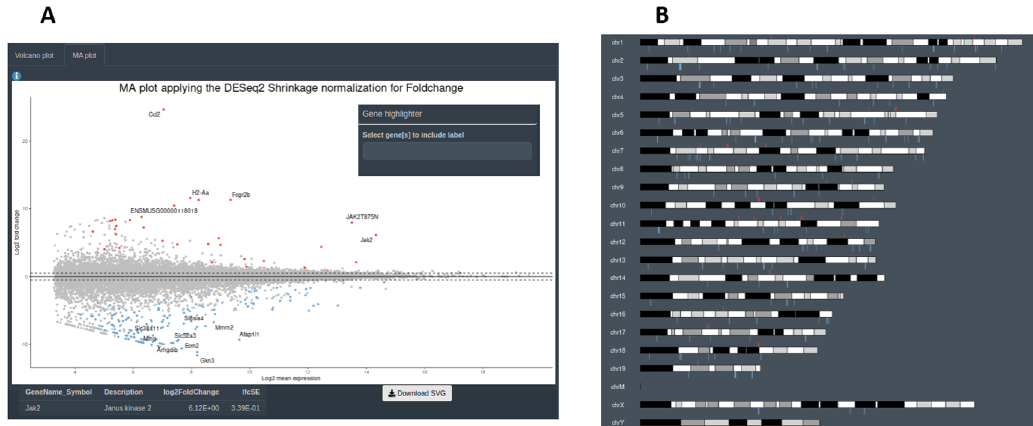
Figure 8. Additional data visualizations available from DEVEA. A: Section to explore volcano and MA plots. B: Karyotype of the top variant genes, regulated by the user; and a dot plot with the expression of the top 6 variant genes or a selection ofindividual genesof interest (Figure 7). Asecond groupof graphs representsgenes related onlytotheir statistical values. This can be displayed from CM + SI, DO and GL + SV modes. They consist in a volcano plot, that shows statistical significance (adjusted p-value) versus the magnitude of change (FC) regarding the contrast levels; and a karyotype plot showingtheDEGpositiononthegenomeandthedirectionofchange(colorcodedbyup-ordown-regulated)(Figure8B). Finally, it is also possible to combine gene expression with statistical values, from CM + SI and DO input modes, to generate a MA plot (an application of a Bland – Altman plot for visual representation of genomics data 22 ) (Figure 8A) displaying feature labels and statistical values by clicking on each gene dot.